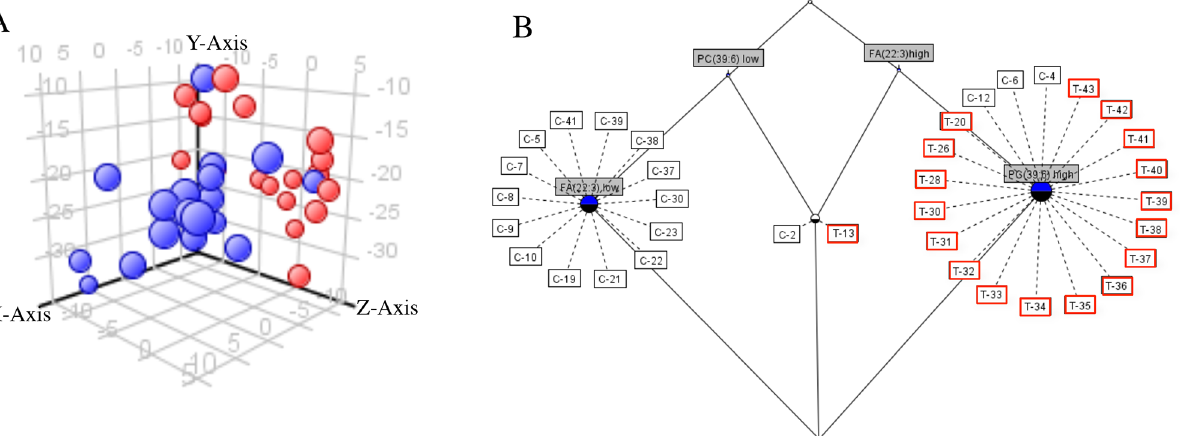
Fig 4. (A) Principal Component Analysis (PCA): Scatter plot of the top three principal components of PCA from the relative abundance of lipid data obtained from cancer and normal individuals. The blue balls indicatePCa patients, whereas red balls show non cancerous individuals. (B) Formal Concept Analysis to visualize sorting of samples based on the relative abundance of PC (39:6) and FC (22:3) in PCa (red squares) compared to control (black squares). This data dependant visualization has been performed to show partition efficiency of lipids individually and/or in combination to identify signature lipids of biomarker potential.